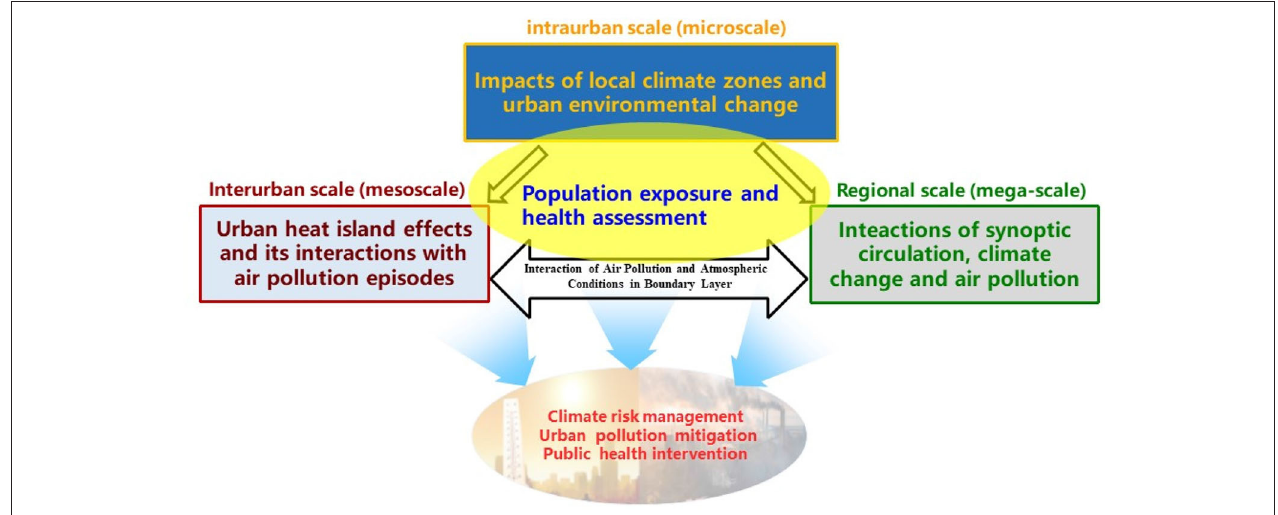
FIGURE 1 | A research framework of urban climate, environmental change and public health